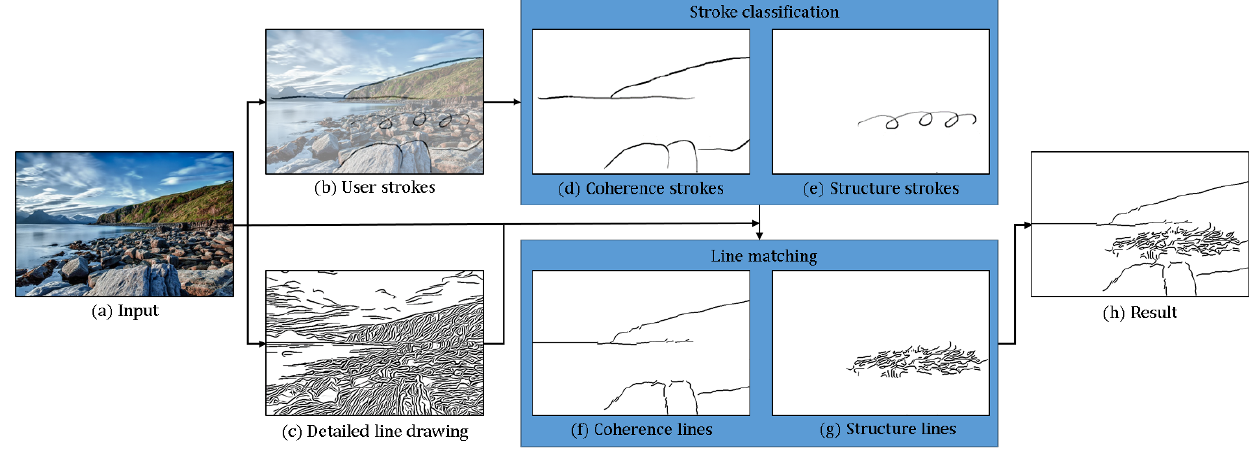
Fig. 2 Overview. Given an input image (a), the system lets the user provide a few simple, intuitive strokes (b) and generates a reference dataset of line segments from a detailed line drawing image (c). Next, the system classifies the user strokes into coherence strokes (d) and structure strokes (e). A novel line matching algorithm is then employed to match the line segments of (c) to the input coherence and structure strokes. The best matching coherence lines (f) and structure lines (g) are combined to form the final line abstraction